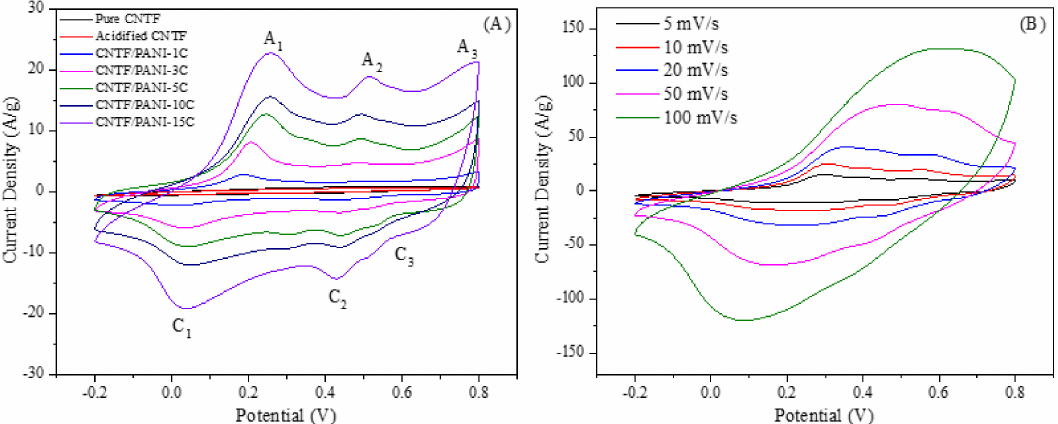
Figure 8. ( A ) CV curves of pure CNTF, acidified CNTF, and CNTF/PANI nanocomposites, mea- sured at a scan rate of 10 mV/s in 1.0-M H 2 SO 4 solution; and ( B ) CV curves of CNTF/PANI-15C